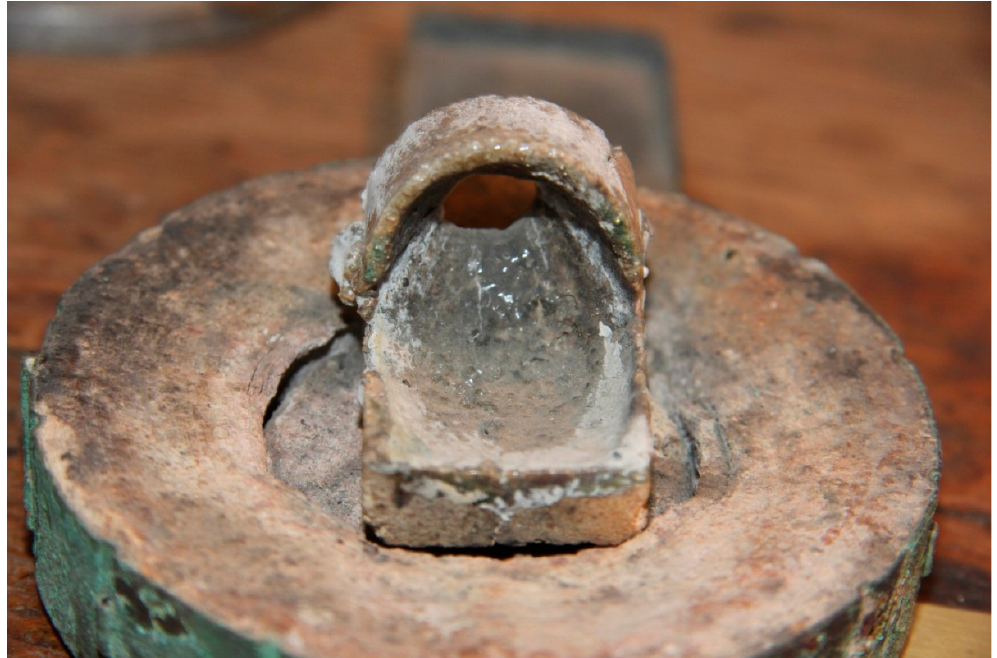
Figure 3. Crucible for melting metals that would be later inserted into a Solbrig-Platshick casting cylinder. Source: Dental Museum. Faculty of Dentistry. University of Granada (2021).